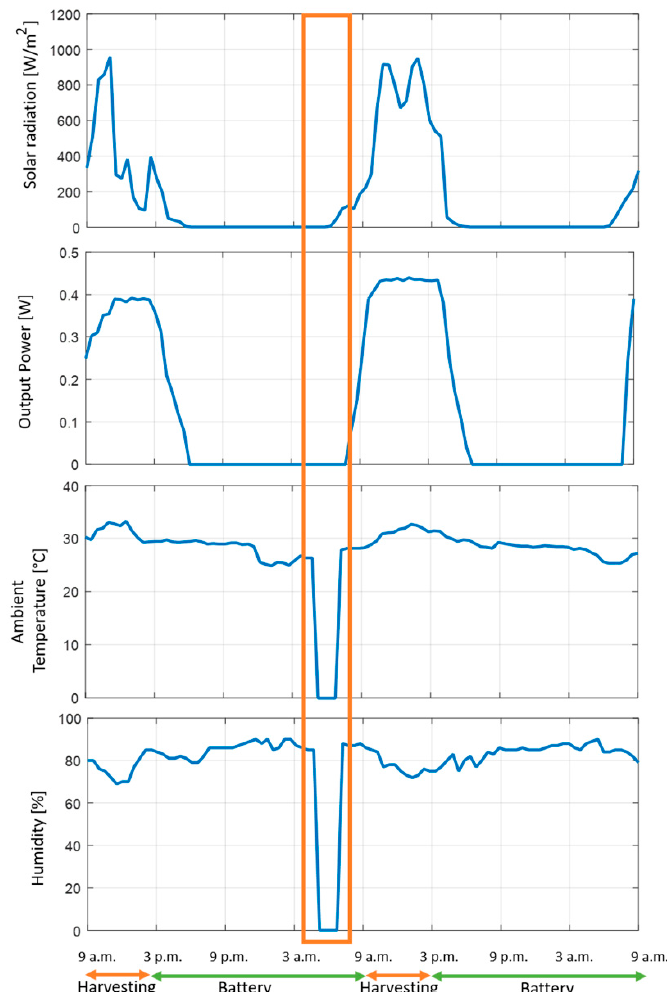
Figure 26. Reports delivered from two consecutive